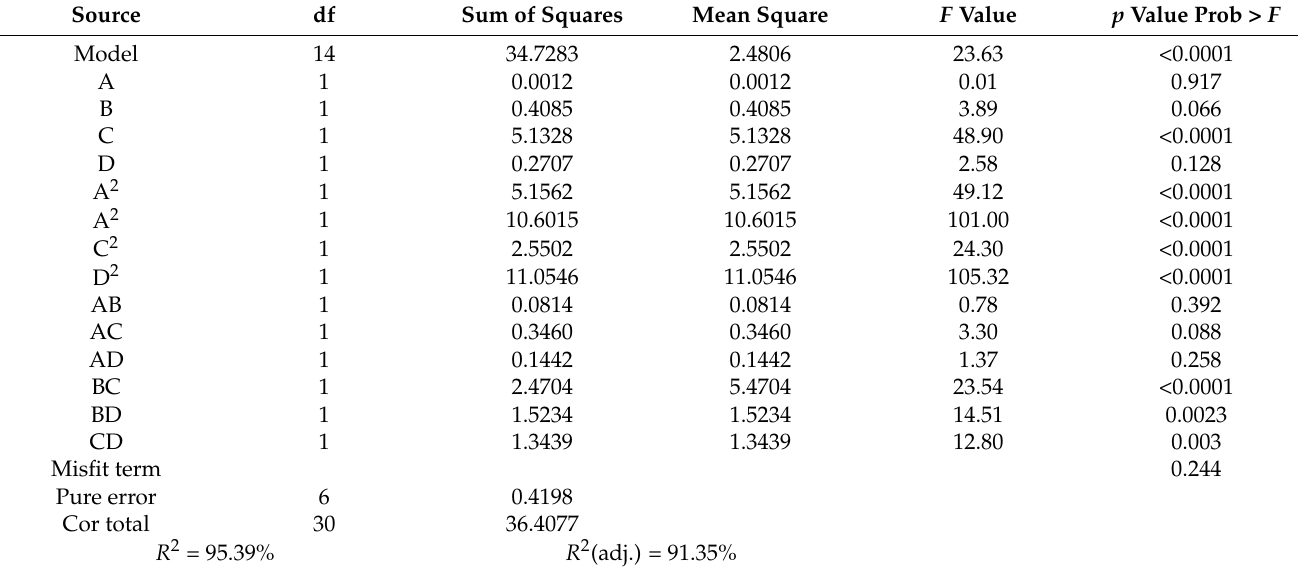
Table 6. Analysis of variance of the response surface